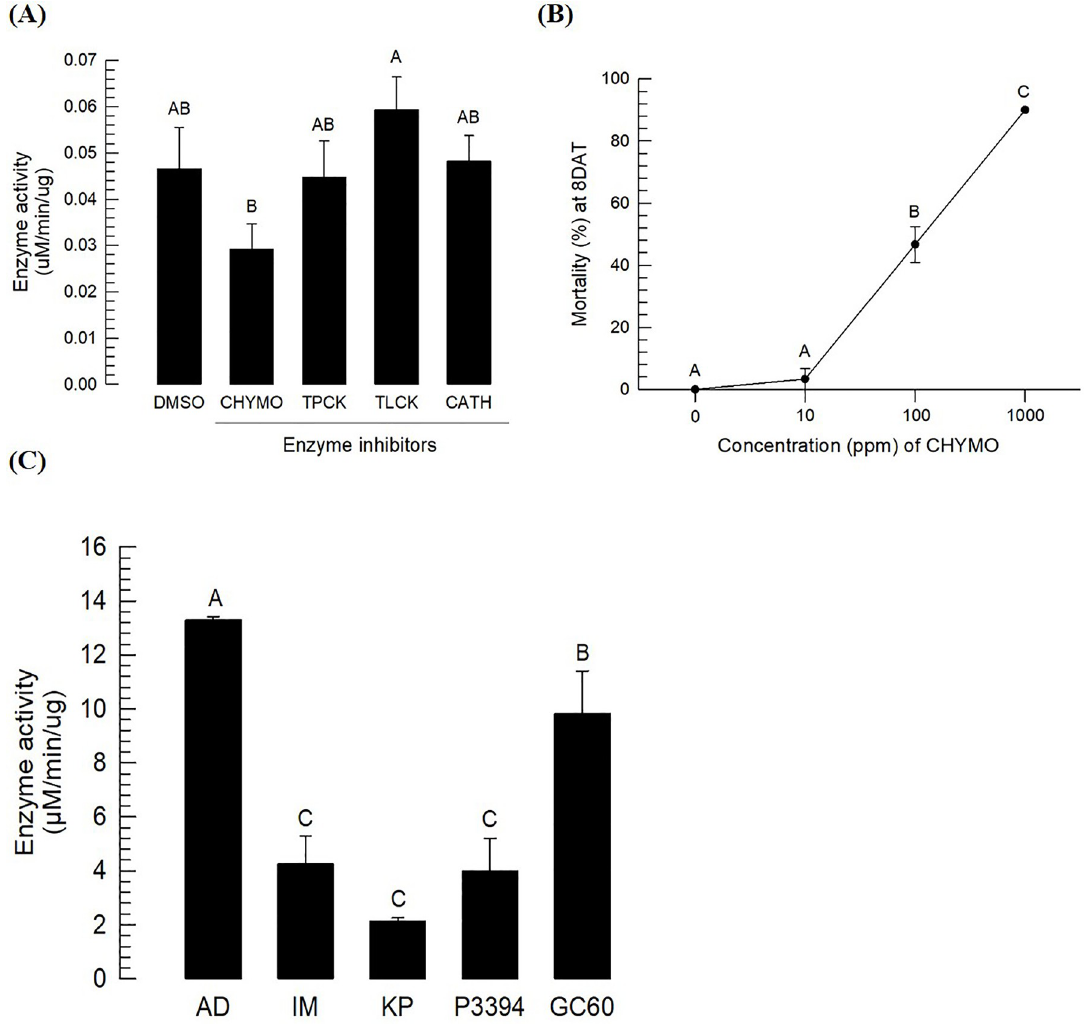
Fig 3. Inhibitory effects of three resistant corn varieties on chymotrypsin activity in the gut juice of O . furnacalis larvae. (A) Chymotrypsin activity of larvae and sensitivity to its specific inhibitors in L3 larvae. All larvae were fed artificial diet treated with 1,000 ppm inhibitors for 3 days. Three L3 larvae were used to collected gut juice. Each treatment was replicated three times. (B) Survival rate of O . furnacalis larvae. L3 larvae were treated with artificial diet treated with different concentrations of inhibitors for 4 days. Survival rates were determined at 8 days after treatment (‘8 DAT’). Each treatment was replicated three times. Ten larvae were used in each replication. ‘CON’ represents solvent (DMSO) treatment without inhibitor. Inhibitors included CHYMO (chymostatin) specific to chymotrypsin; TPCK (tosyl-phenylalanyl chloromethyl ketone) specific to chymotrypsin; TLCK (tosyl-L-lysyl- chloromethane hydrochloride) specific to trypsin, and CATH (cathepsin III inhibitor) specific to cathepsin. (C) Suppression of chymotrypsin activities of L5 larvae fed with leaves of three resistant corn varieties (Ilmichal (‘IM’), Kwangpyeongok (‘KP’), and P3394). The control used artificial diet (‘AD’). Each treatment was replicated three times. Each replication used the midgut juice of three L5 larvae. Different letters above standard error bars indicate significant difference among means at Type I error = 0.05 (Tukey